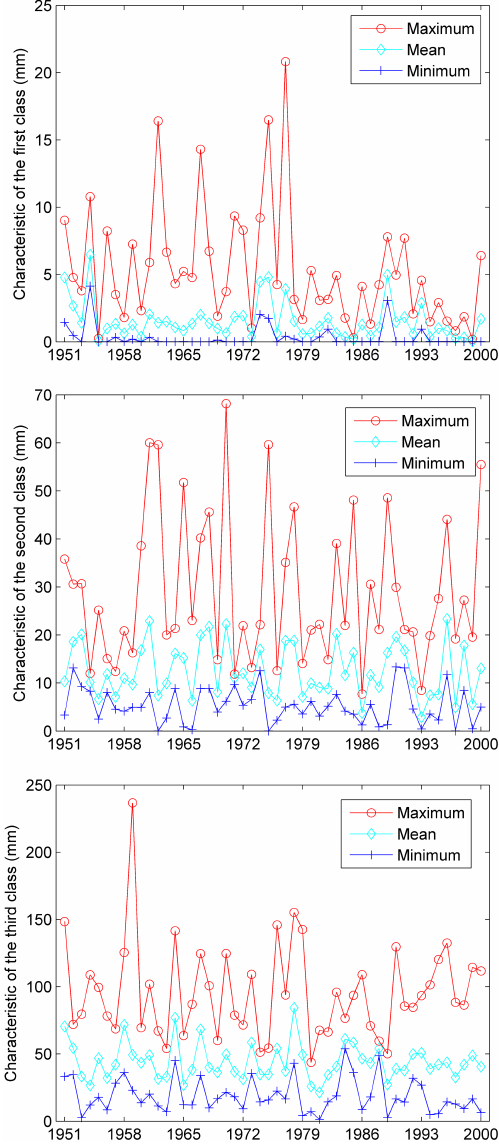
 Class 1: Jan., Feb., Nov., and Dec.  Class 2: Mar., Apr., and Oct.  Class 3: May, Jun., Jul., Aug., and